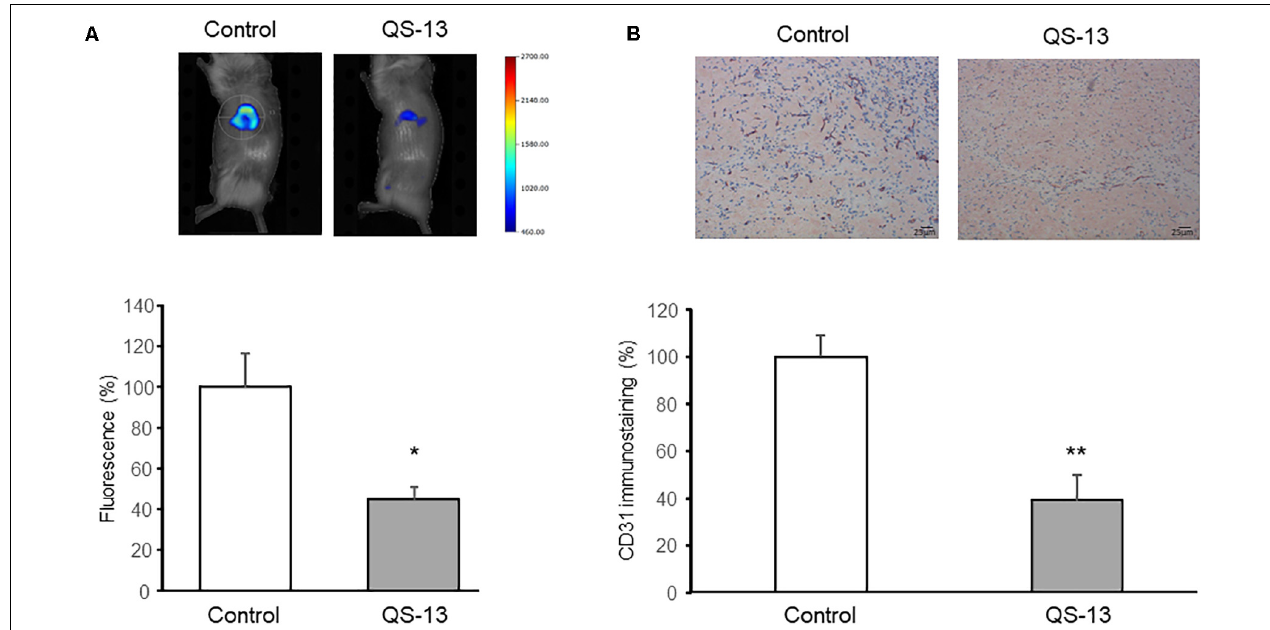
FIGURE 1 | QS-13 decreases in vivo angiogenesis in a Matrigel plug model. Matrigel (400 µ L) was subcutaneously injected into mice. After 13 days of treatment with VEGF alone or with VEGF and QS-13, a fluorescent imaging agent was administrated. (A) At day 14, anesthetized mice were imaged using molecular fluorescence tomography and FMT signal intensities were measured. (B) Matrigel plugs were then excised, CD31-immunostaining was performed on Matrigel plug sections and microvessel density (MVD) was evaluated. Two independent experiments ( N = 2) were carried out with 4 mice in each group ( n = 4). The histograms represent the means of the two experiments ± SD. * p < 0.05; ** p <